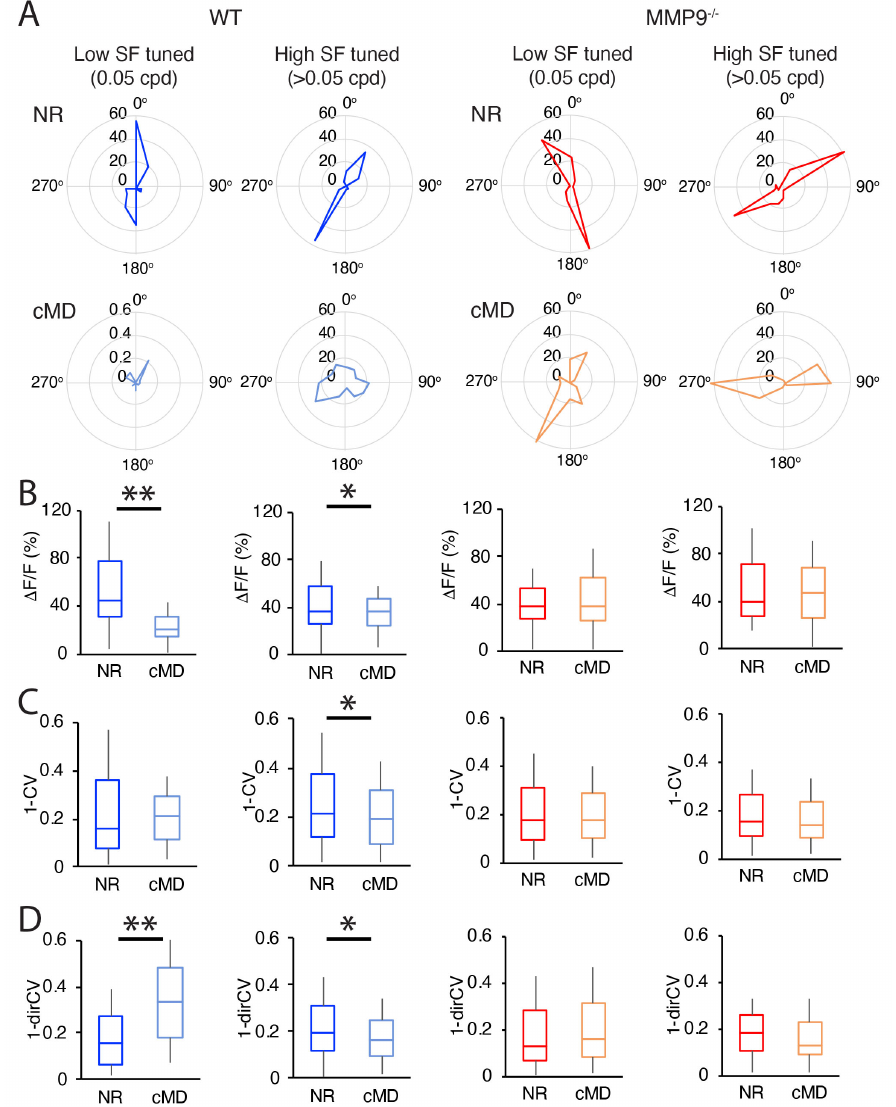
Figure 6. Orientation and direction selectivity are impacted by cMD in WT but not MMP9 − / − mice. ( A ) Representative polar plots of low spatial frequency (SF) tuned (0.05 cpd) and high SF tuned (> 0.05 cpd) neurons of WT and MMP9 − / − mice. NR WT (dark blue) and cMD WT (light blue), NR MMP9 − / − (red), and cMD MMP9 − / − (orange). Scale: Δ F/F (%). ( B ) cMD significantly decreased Δ F/F in WT but not MMP9 − / − mice. ( C ) Orientation selectivity (1 ‐ CV) in high SF tuned (> 0.05 cpd) neurons is lower in cMD (light blue) than NR (dark blue) WT (left) but not MMP9 − / − (right, red for NR and orange for cMD) mice. ( D ) Direction selectivity (1 ‐ dirCV) is higher in low SF tuned neurons (0.05 cpd) in cMD (light blue) than NR (dark blue), and lower in high SF tuned (> 0.05 cpd) neurons in cMD WT, but not in MMP9 − / − mice. Box plots represent median as a bar, 25th to 75th percentile as box, and max and min as whiskers, * p < 0.05, ** p < 0.001, Student’s t ‐ test, n = 59, 51, 94, 95, 208, 88, 104, and 160 neurons for LSF NR WT, LSF cMD WT, HSF NR WT, HSF cMD WT, LSF NR MMP9 − / − , LSF cMD MMP9 − / − , HSF NR MMP9 − / − , and HSF cMD MMP9 − / − , respectively.